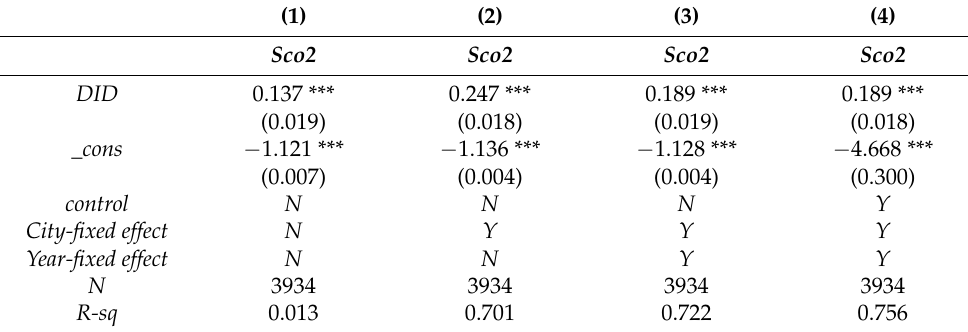
Table 2. Baseline